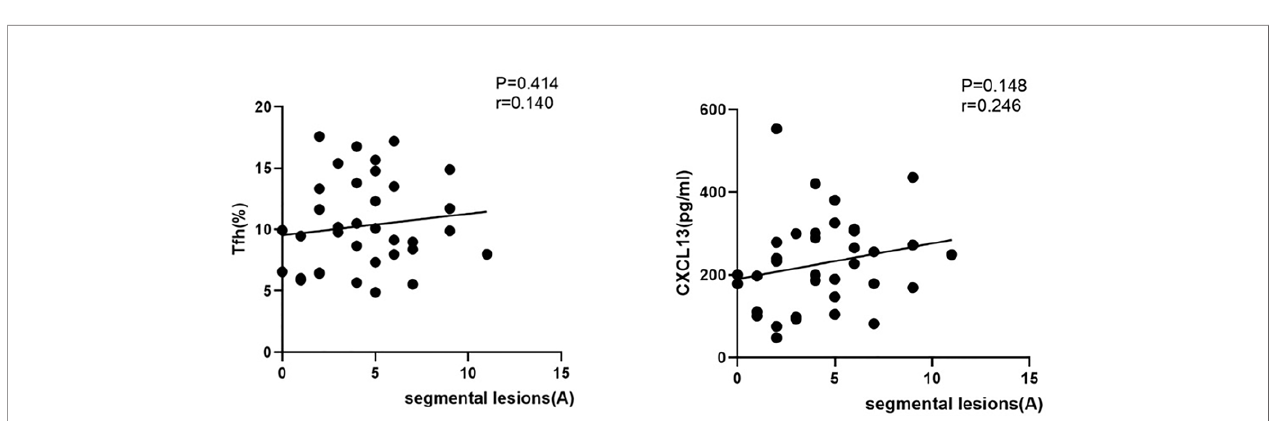
FIGURE 4 | Correlations among the proportion of circulating Tfh cells, serum CXCL13 levels, and segmental lesions in patients with NMOSD. (Correlation among the proportion of circulating Tfh cells, serum CXCL13 levels and segmental lesions in NMOSD patients with positive serum antibodies. A, acute phase of NMOSD; r: correlation coef fi cient.